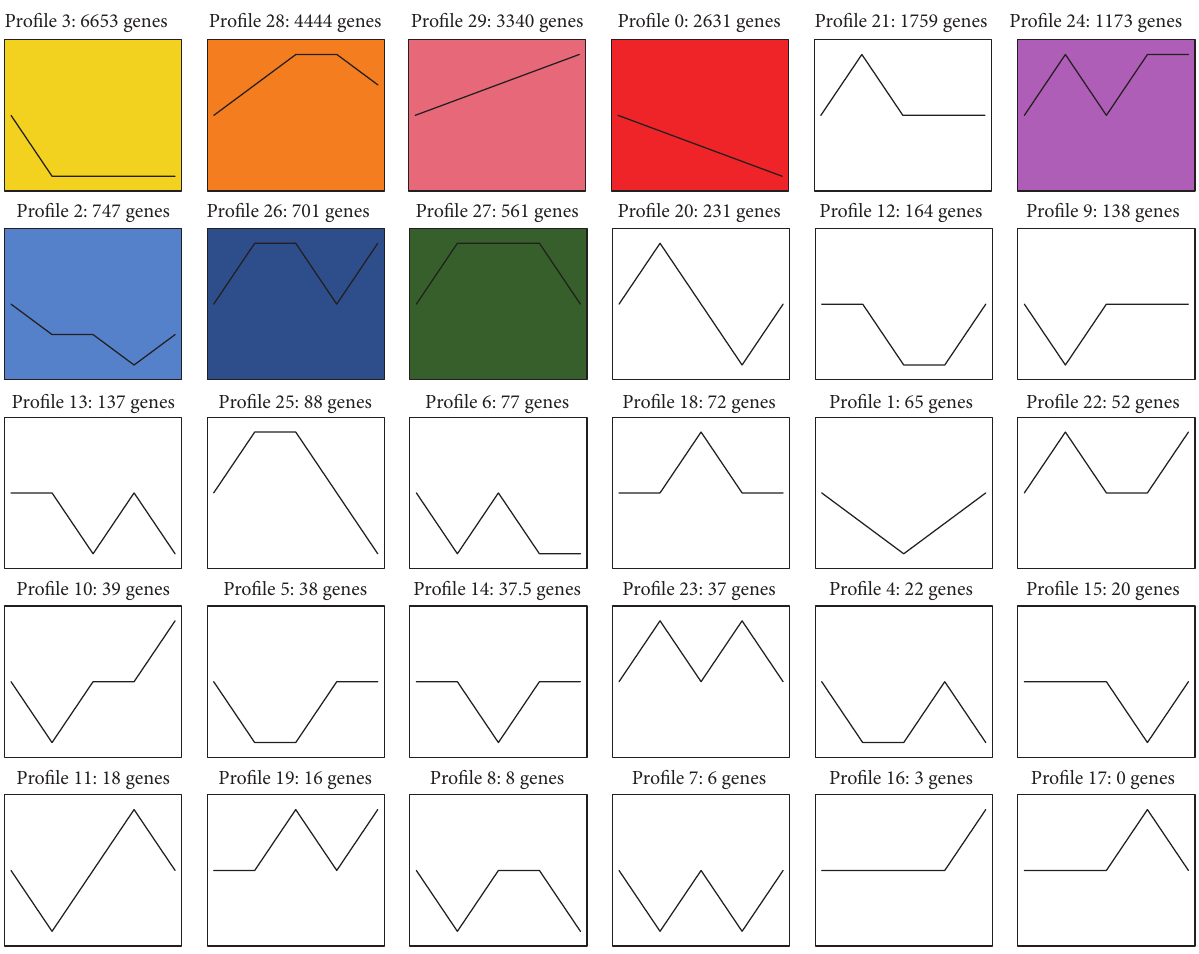
Figure 8: Expression trends of unigenes across trochophore, D-shaped, umbonal, eyespots, and spats larval stages of Pinctada fucata . The profiles were ordered based on the 𝑃 value of the number (at bottom-left corner) of genes assigned versus expected. Color square frames denote significant profiles ( 𝑃 ≤ 0.01 ). Each graph displays the mean pattern of expression (black lines) of the profiled genes. The number of profiles in each cluster is indicated in the top left corner. The 𝑥 -axis represents stages and the 𝑦 -axis represents log 2-fold change of gene